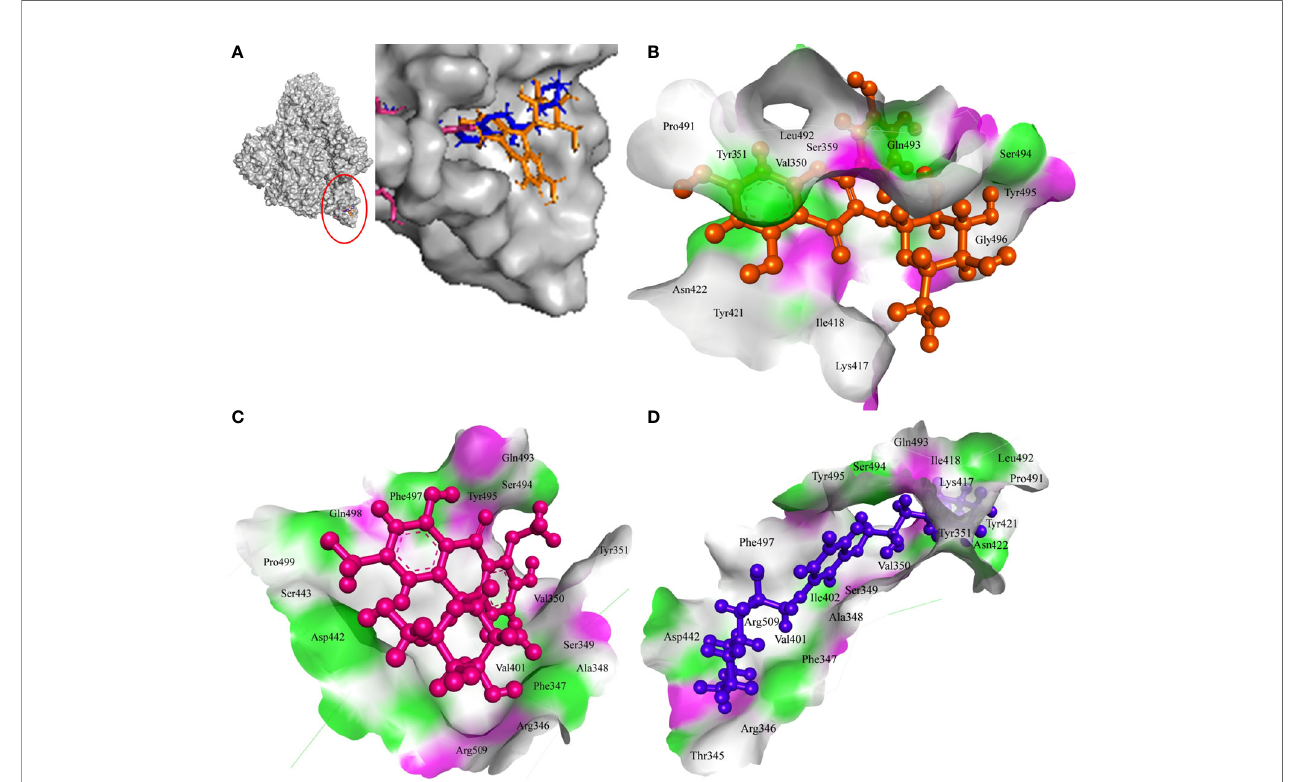
FIGURE 3 | Interaction of lead phytochemicals and standard inhibitor with RdRp protein of SARS-CoV-2. (A) Binding pose of VE607 (Blue), Isoquercetin (Orange), and 10-Hydroxyaloin A (Pink) at the active site of the RdRp. (B) Interaction of RdRp active site with isoquercetin shown with the hydrogen bond surface of receptor. (C) Interaction of RdRp active site with 10-Hydroxyaloin A shown with the hydrogen bond surface of receptor. (D) Interaction of RdRp active site with VE607 shown with the hydrogen bond surface of